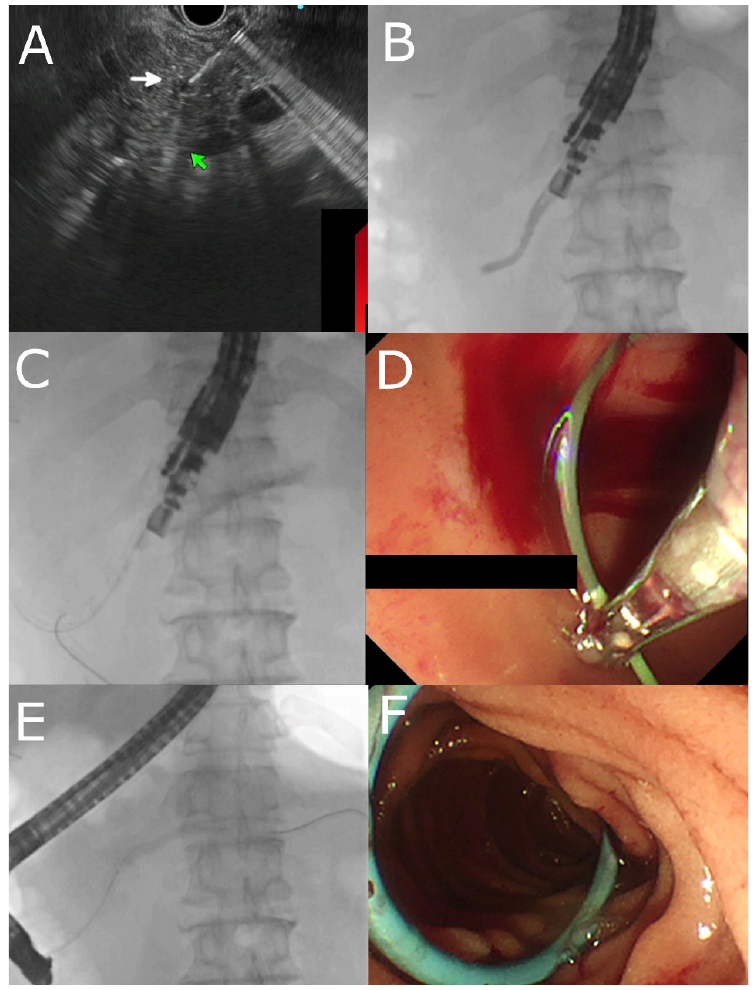
Figure 1. EUS ‐ guided rendezvous ERP in a patient with pancreatic divisum and failed minor papilla cannulation. ( A ) EUS ‐ guided puncture of the pancreatic duct (indicated by white arrow ). ( B ) Contrast injection showing pancreatogram. ( C ) Passage of guidewire into the duodenum. ( D ) Grabbing the guidewire from the duodenal lumen after changing to a duodenoscope with micro ‐ forceps. ( E ) Main pancreatic duct recannulated with a guidewire. ( F ) Insertion of a pancreatic duct stent after minor papillotomy.